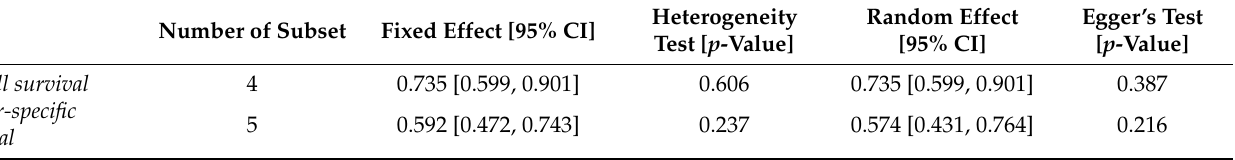
Table 5. Comparisons of prognosis between colorectal cancer with and without CDX2